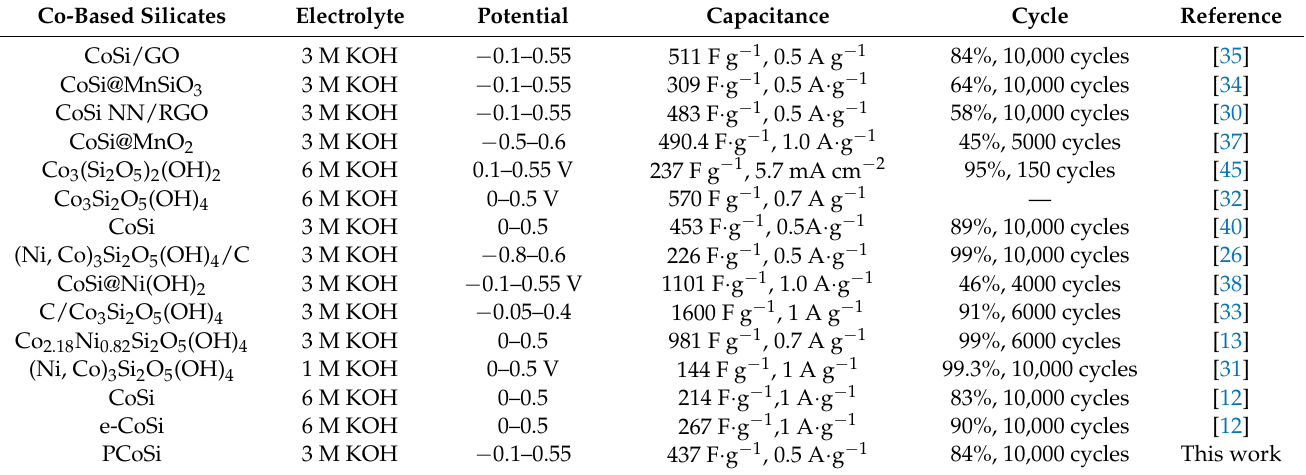
Table 1. Comparison of the specific capacitance of the as-obtained PCoSi with the state-of-the-art silicate materials in the